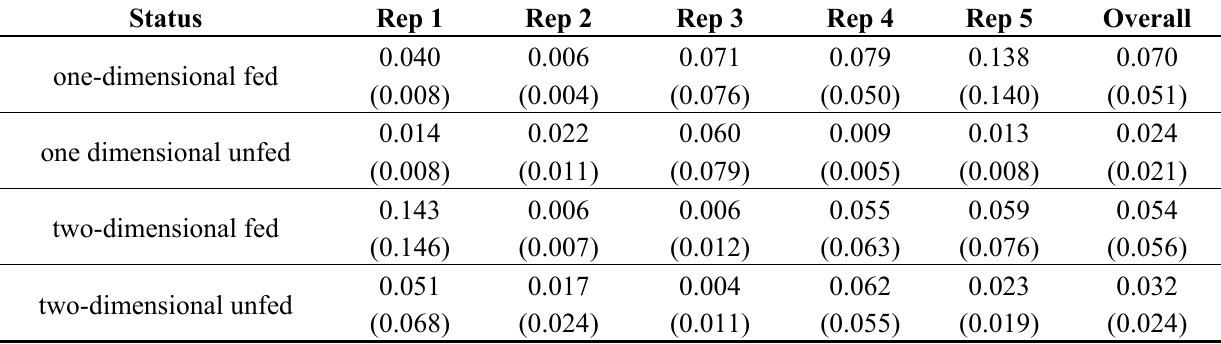
Table 2. Mean diffusion rates using (IC 1 ) in cm 2 /s of fed vs. unfed bed bugs in one- and two-dimensional arenas, standard deviation in